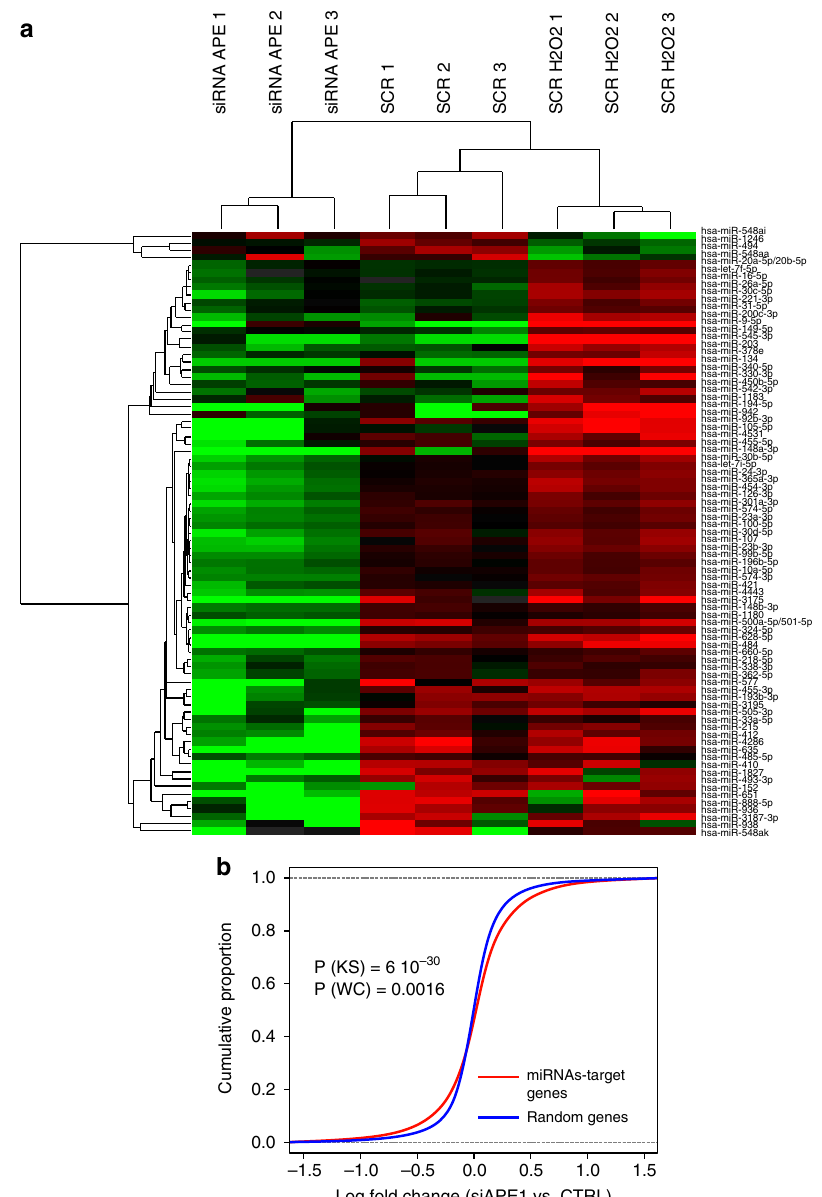
Fig. 1 miRNA pro fi ling of H 2 O 2 -treated and APE1-knocked down HeLa cells. a Hierarchical-clustering analysis showing miRNAs differentially expressed in HeLa cell clones stably transfected with scrambled siRNA control ( SCR ), with an APE1 siRNA ( siAPE ) or SCR after stimulation with 1 mM H 2 O 2 for 15 min. The heatmap diagram shows the centered miRNA expression values in logarithmic scale across the three groups of samples. b Empirical cumulative distribution function ( ECDF ) curves for expression changes (log fold change) of miRNAs-target genes ( red line ) vs. those of random mRNAs ( blue line ). Statistical signi fi cance of the difference between ECDFs is indicated ( P -value from Kolmogorov – Smirnov ( KS ) test and Wilcoxon ( WC